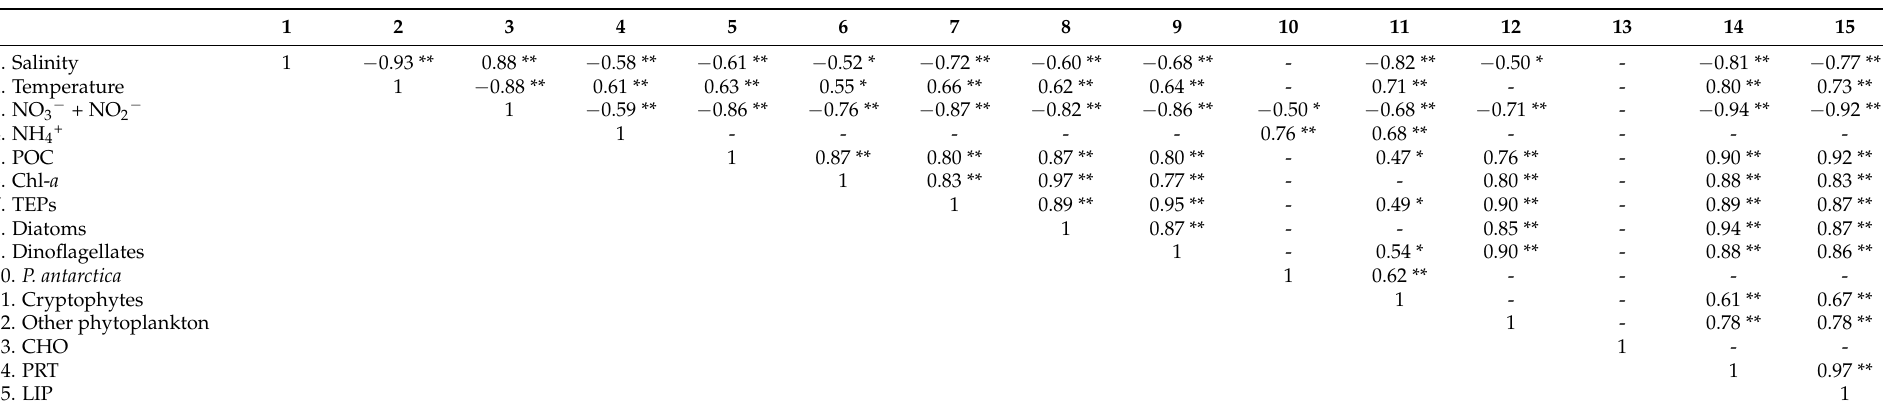
Table 1. Pearson’s correlation analysis for the environmental factors and biochemical